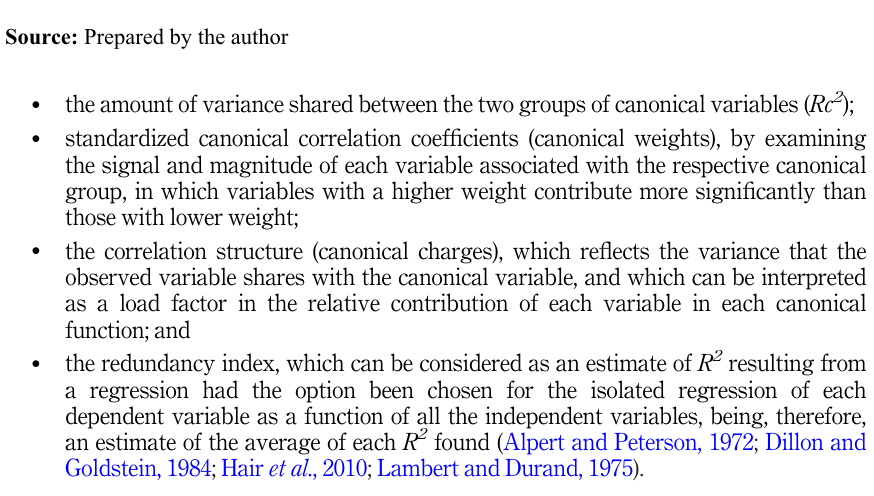
Figure 1. Scheme of canonical correlation between the learning mechanisms